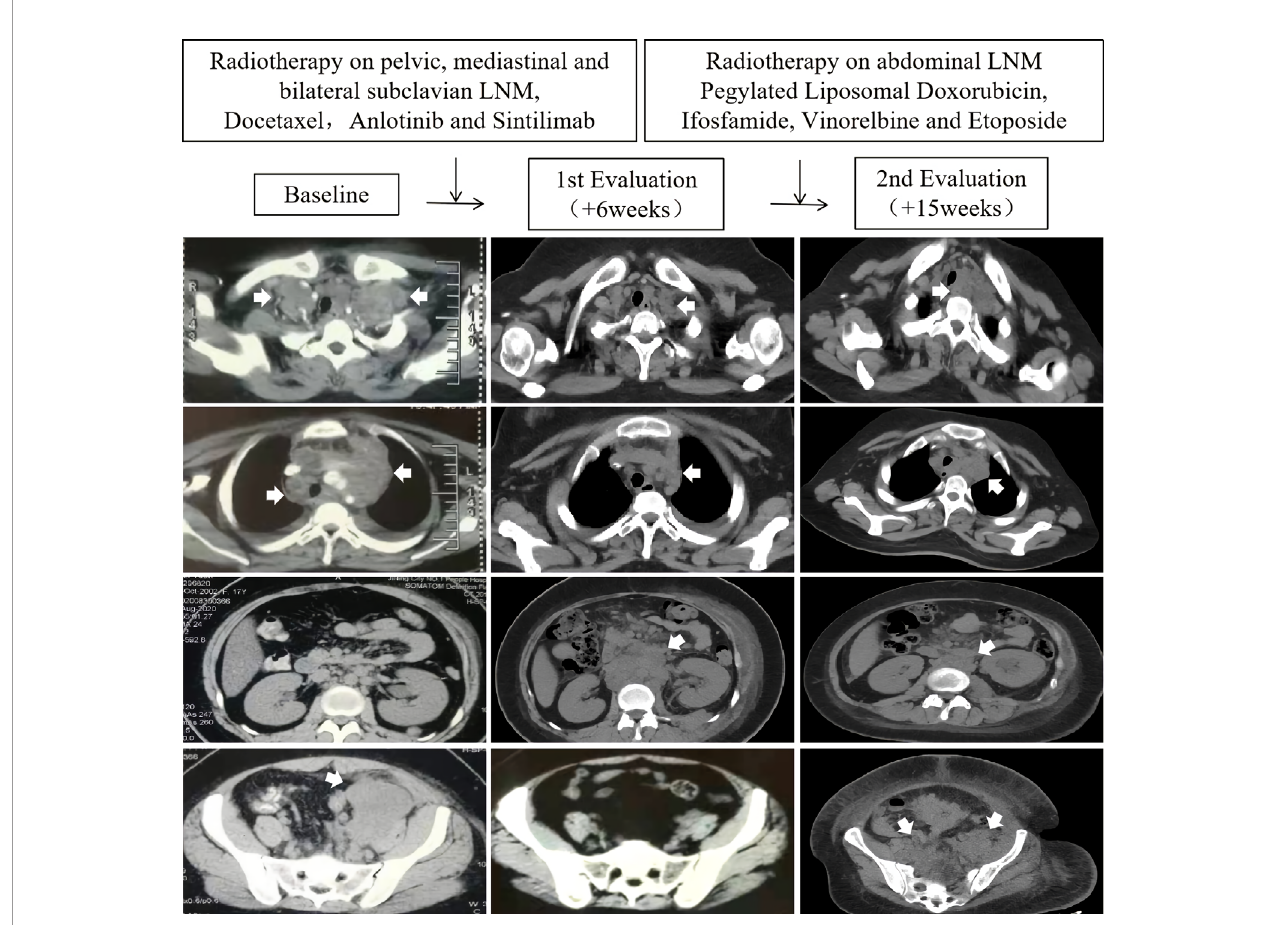
FIGURE 1 | Scans at baseline, fi rst evaluation (+6 weeks), and second evaluation (+15 weeks) in a SS18-POU5F1 sarcoma patient with multiple lymph node metastases (LNM) who accepted immune checkpoint inhibitor, angiogenesis inhibitor, chemotherapy and